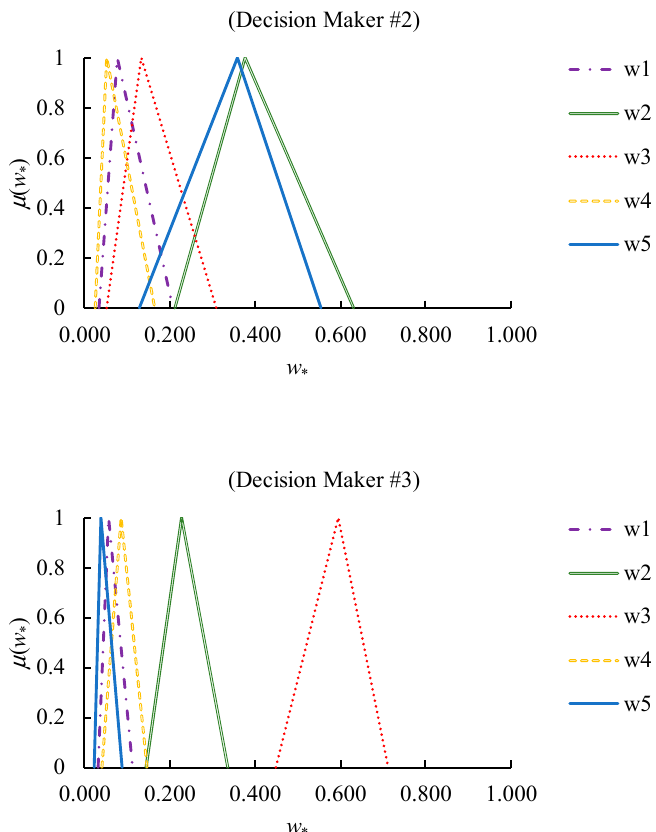
Figure 4. The relative priorities evaluated by the decision makers.